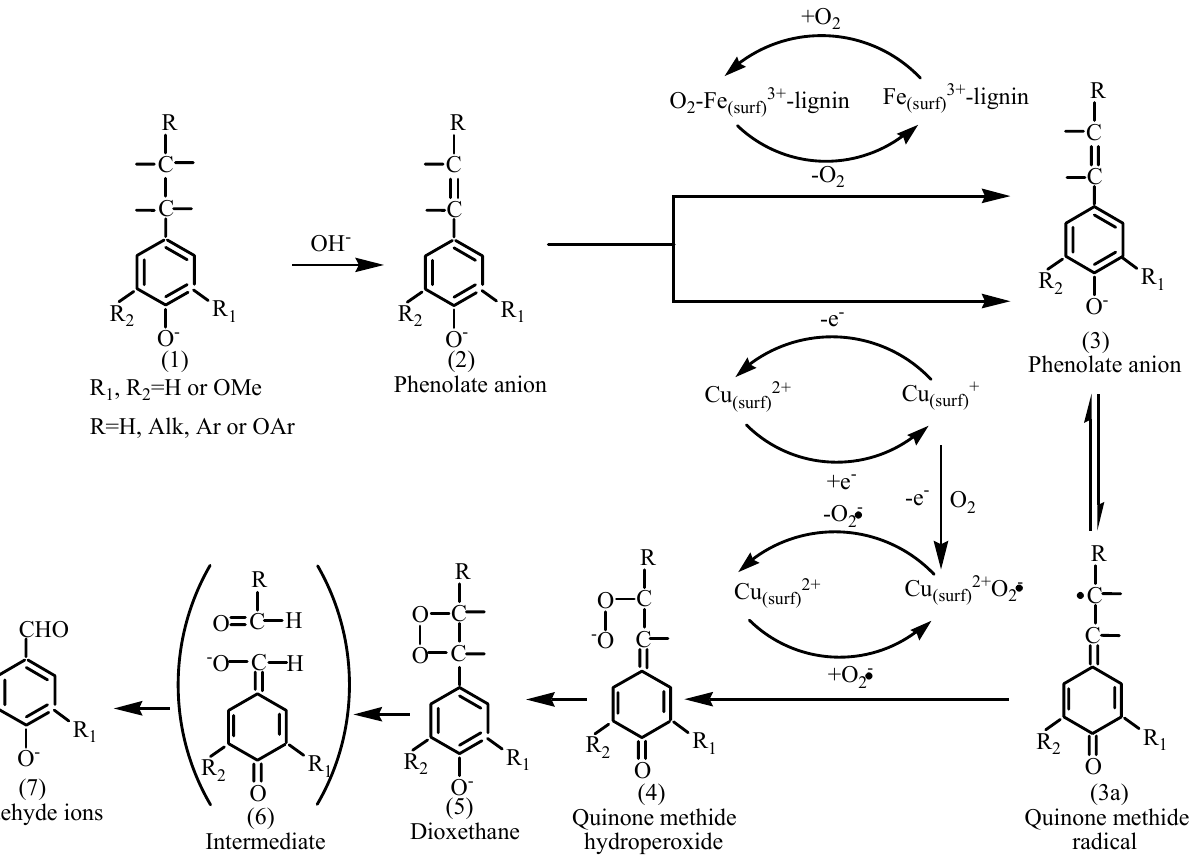
Figure 6. Proposed mechanism of oxidation of lignin in the LaFe catalyst